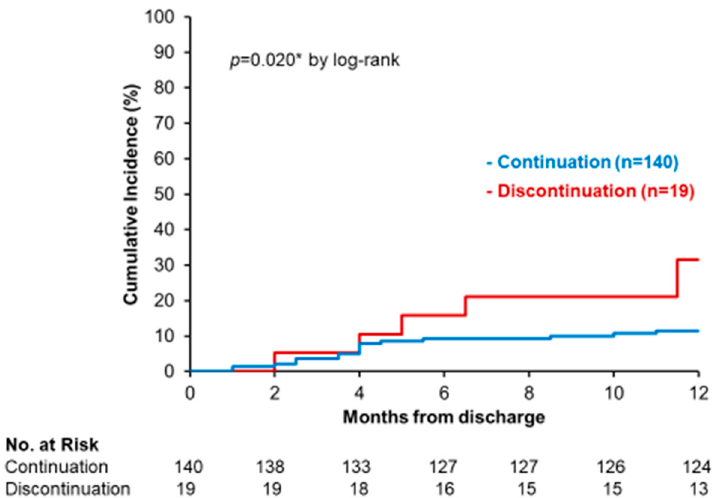
Figure 3. Recurrent hospitalization for heart failure or cardiovascular death in patients with continued SGLT2 inhibitors versus those with discontinued SGLT2 inhibitors. * p < 0.050.